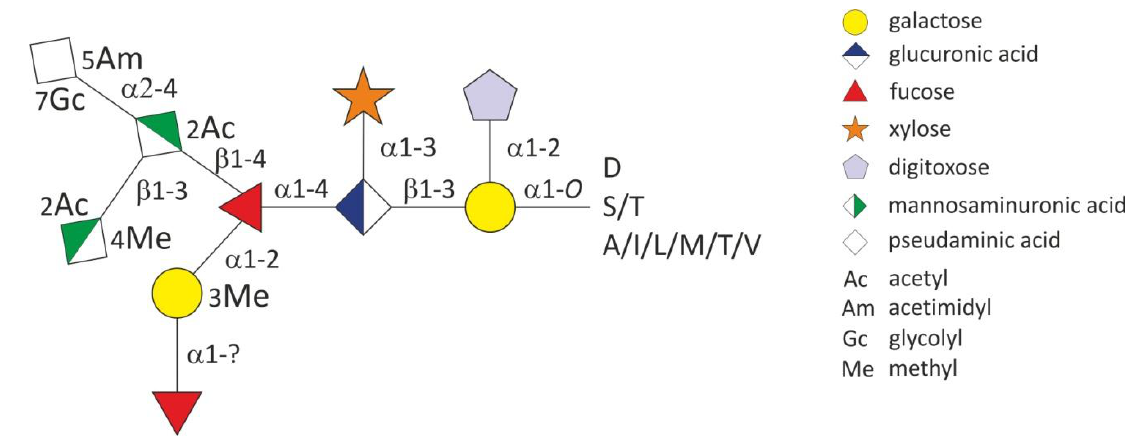
Figure 2. Schematic drawing of the structure of the abundant O -glycan in T. forsythia . Modified from